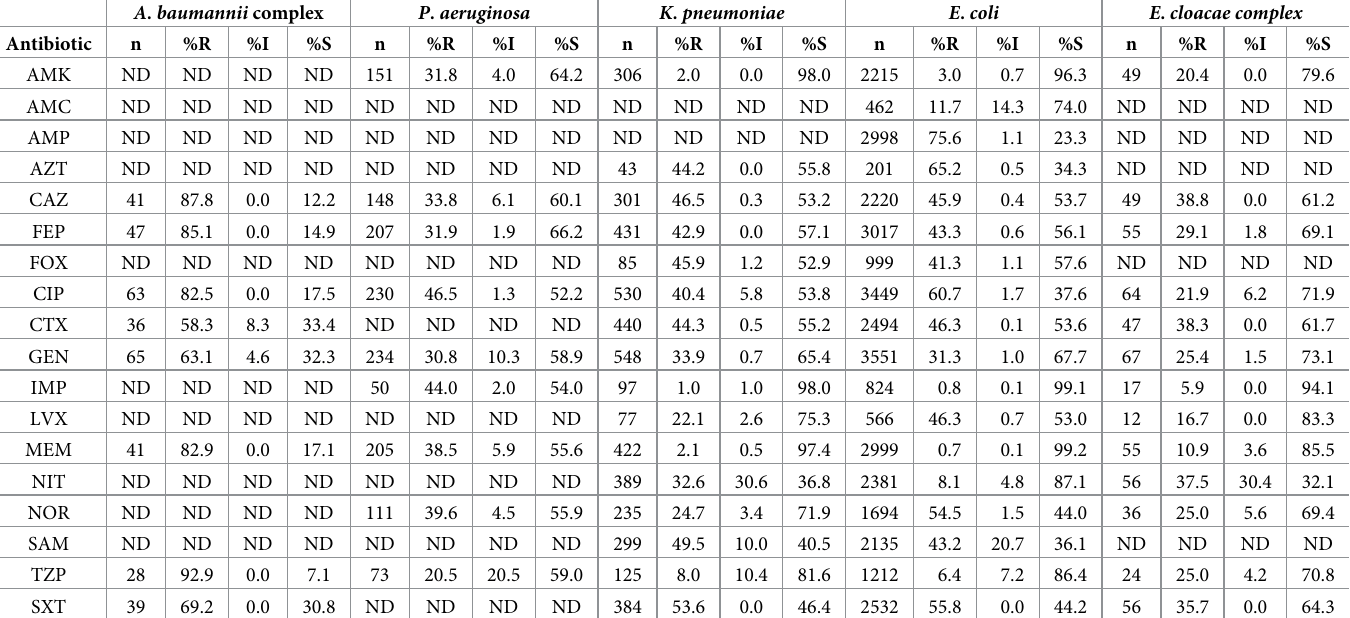
Table 2. Percentage of resistant, intermediate, and susceptible gram-negative isolates collected from